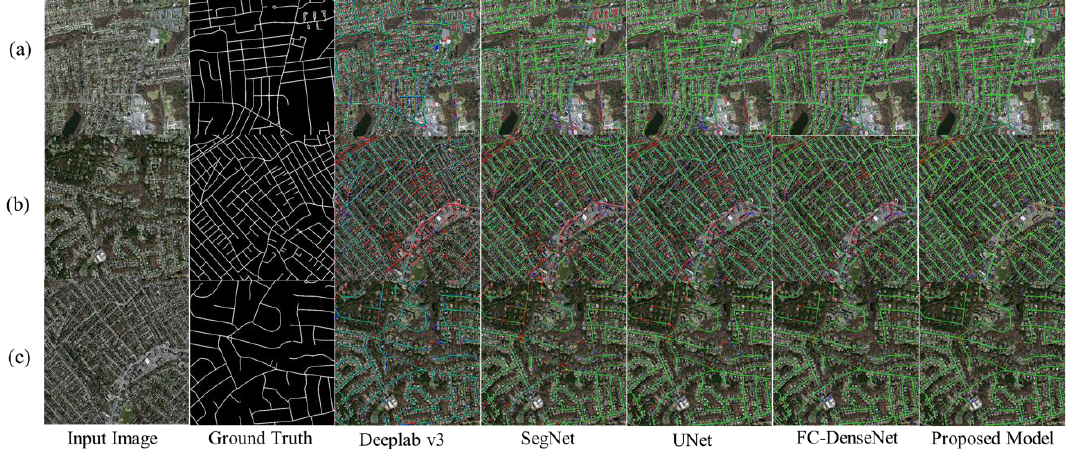
Figure 12. Visual comparison of Nested SE-Deeplab and other deep-learning models on the testing dataset. True positive (TP) is marked as green, false positive (FP) as blue, and false negative (FN) as red. The three rows including ( a ), ( b ) and ( c ) in the figure contains visual effects of three examples in testing set, which have been tested by different models. For each row in the figure, it contains an input image, a picture of ground truth and five results of road extraction models including Deeplab v3, SegNet, UNet, FC-DenseNet and Nested SE-Deeplab.